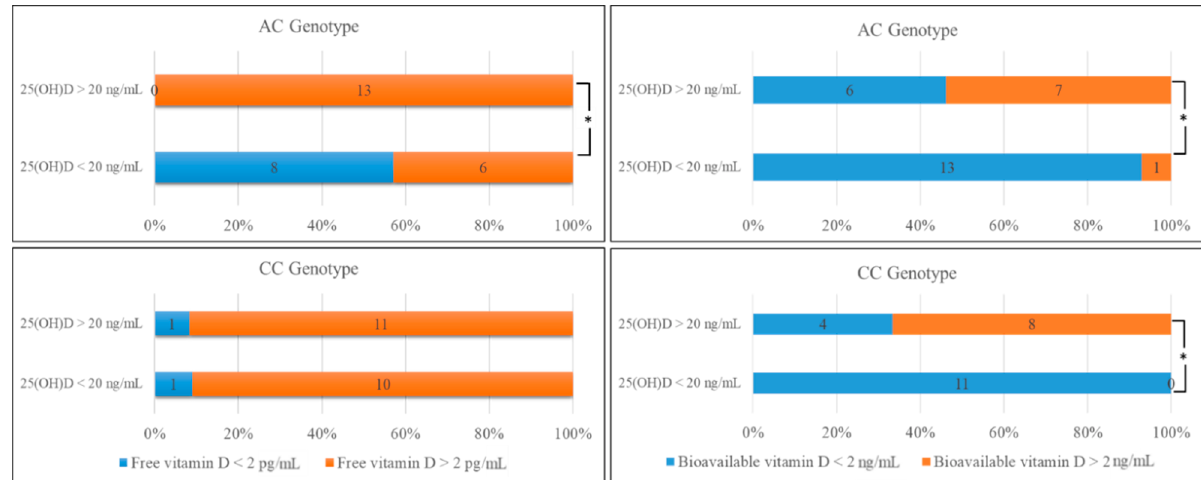
Figure 2. Comparison of the number of individuals with AC and CC genotypes according to serum 25(OH)D levels compared with the free and bioavailable 25(OH)D levels. * p < 0.05 indicates the significance level. Table 5. Comparison of the phenotypes of GC gene according to biochemical parameters.